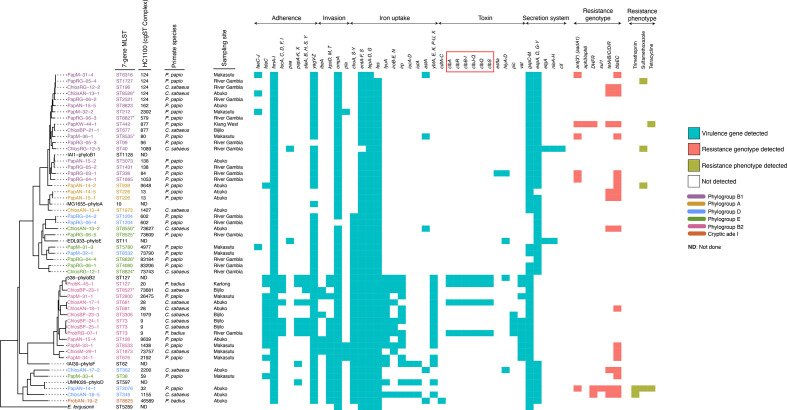
Plot showing the maximum-likelihood phylogeny of the study isolates overlaid with the prevalence of putative virulence genes and resistance-associated genes, as well as the phenotypic antimicrobial resistance among the study isolates. The tree was reconstructed based on non-repetitive core SNPs calculated against the
E. coli
 K-12 reference strain (NCBI accession: NC_000913.3), using RAxML with 1000 bootstrap replicates.
E. coli
 MG1655 was used as the reference and
E. fergusonii
 as the outroot species. Recombinant regions were removed using Gubbins [31]. The tip labels indicate the sample IDs, with the respective in silico Achtman STs and HC1100 (cgST complexes) indicated next to the tip labels. Both the sample IDs and the STs (Achtman) are colour-coded to indicate the various phylogroups as indicated. Novel STs (Achtman) are indicated by an asterisk (*).
Escherichia fergusonii
 and the
E. coli
 reference genomes representing the major
E. coli
 phylogroups are in black. Primate species are indicated by strain names as follows: Chlorocebus sabaeus, ‘Chlos’; Papio papio, ‘Pap’; Piliocolobus badius, ‘Prob’. These strain designations are also used in annotating the plot next to the tree. The sampling sites are indicated as follows: BP, Bijilo forest park; KW, Kiang-West National park; RG, River Gambia National Park; M, Makasutu Cultural forest; AN, Abuko Nature reserve; K, Kartong village. These site designations are also used in annotating the plot next to the tree. Cocolonising seven-allele (Achtman) STs in single individuals are shown by the prefix of the strain names depicting the colony as 1, 2 up to 5. We do not show multiple colonies of the same Achtman ST recovered from a single individual. In such cases, only one representative is shown. Virulence genes are grouped according to their function, with genes encoding the colibactin genotoxin highlighted with a red box. The full names of virulence factors are provided in File S7. The resistance-associated genes detected among the study isolates and the class of antibiotic to which they encode resistance are as follows: ant(3′′) (aadA1) and aph3/aph6, aminoglycosides; DHFR, trimethoprim; sul1, sulphonamides; tetA/B/C/D/R, tetracyclines; blaEC, beta-lactamase (penicillinase-type).